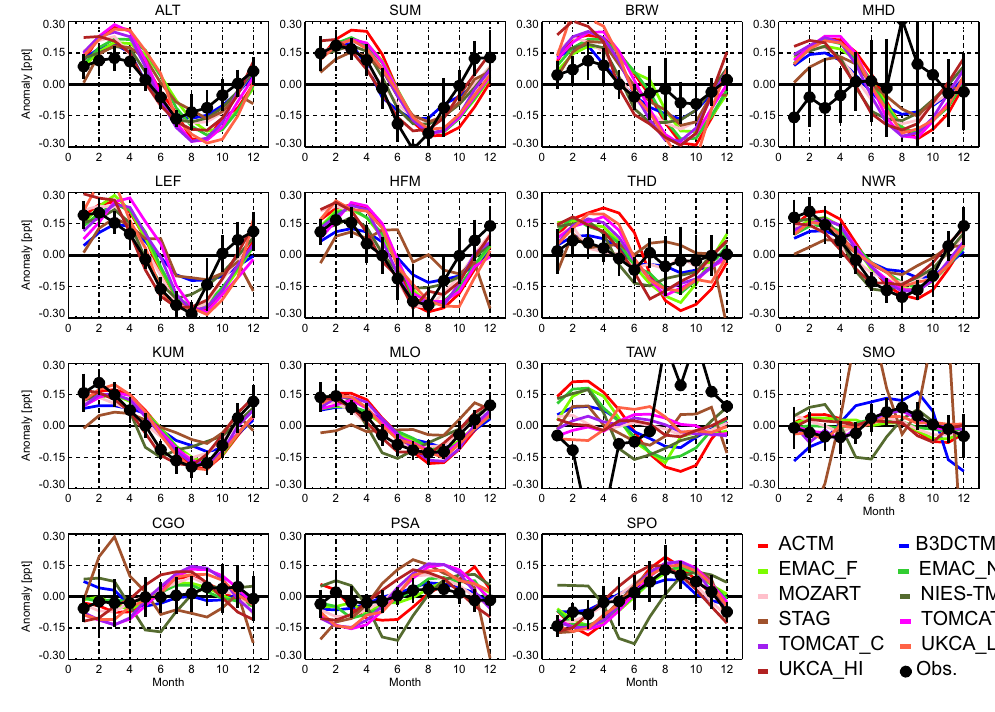
Figure 4. As Fig. 3 but for CH 2 Br 2 . Table 5. As Table 4 but for CH 2 Br 2